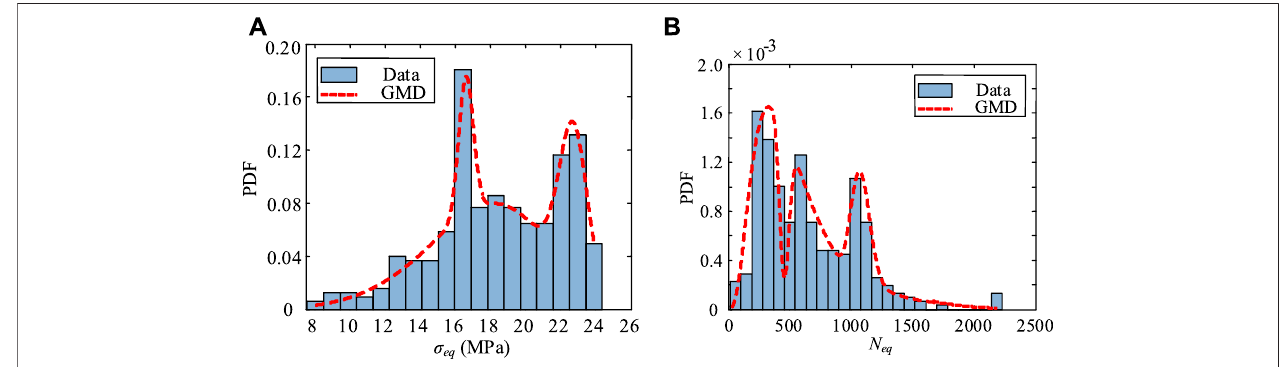
FIGURE 7 | The statistical characteristics of equivalent fatigue loading effects in the upstream side: (A) Daily equivalent stress amplitude, (B) Daily equivalent cycle number.